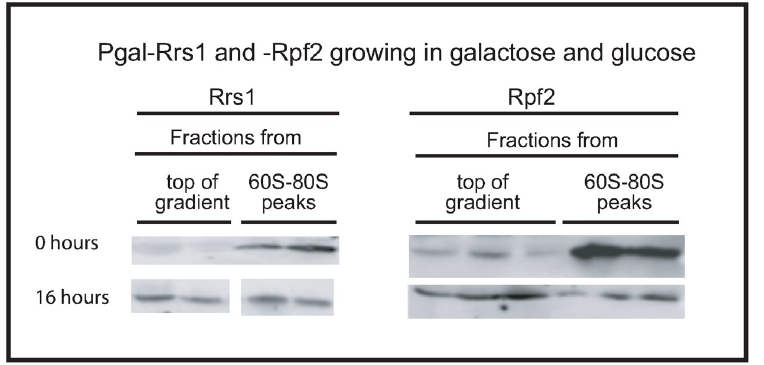
Fig 7. Accumulation of extra-ribosomal uL18 does not require formation of the complete uL18-uL5- 5SrRNA-Rrs1-Rpf2 complex. P gal -Rrs1 and -Rpf2 were grown in galactose medium and shifted to glucose medium for 16 hours. Whole-cell extracts were analyzed by sucrose gradient centrifugation and aliquots of two or three fractions from the top of the gradient and two fractions from the 60S-80S peaks were analyzed by western blots developed with antiserum specific to uL18/L5. Consecutive fractions from the top and the 60S-80S region of the sucrose gradient were